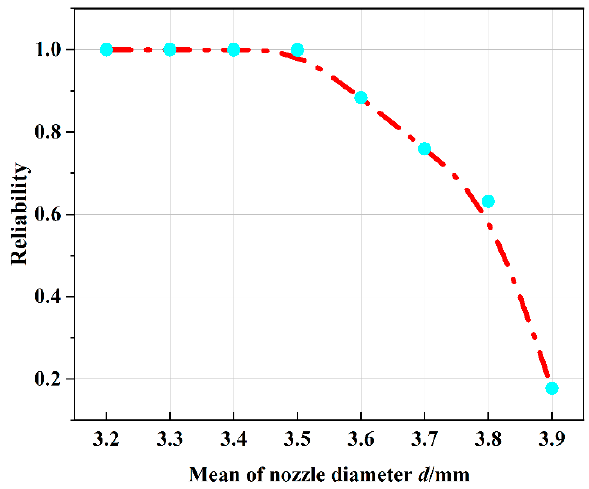
Figure 10. Reliability results with different means of the variable d.